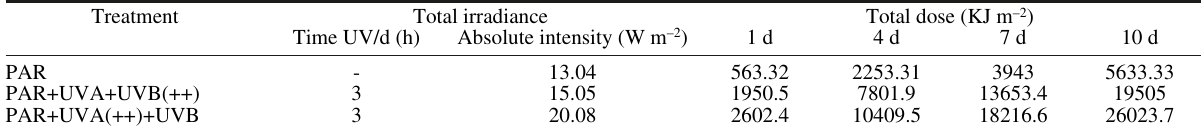
Table 1. – Values of total radiation doses and intensities for PAR, PAR+UVA+UVB (++) and PAR+UVA (++) +UVB treatments. The total dose was calculated from the absolute intensity values for 1, 4, 7 and 10 days (d). UVA and UVB irradiance were 2.01 W m –2 and 7.04 W m –2 , respectively.